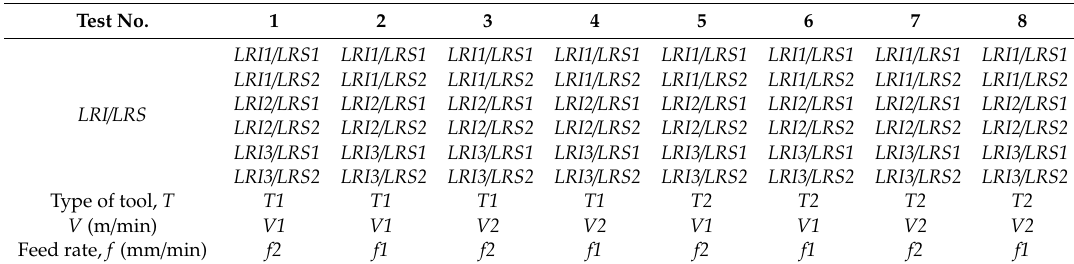
Table 8. Mg-Ti-Mg specimen experimental design: product of a full factorial 2 3 and a block of two factors.